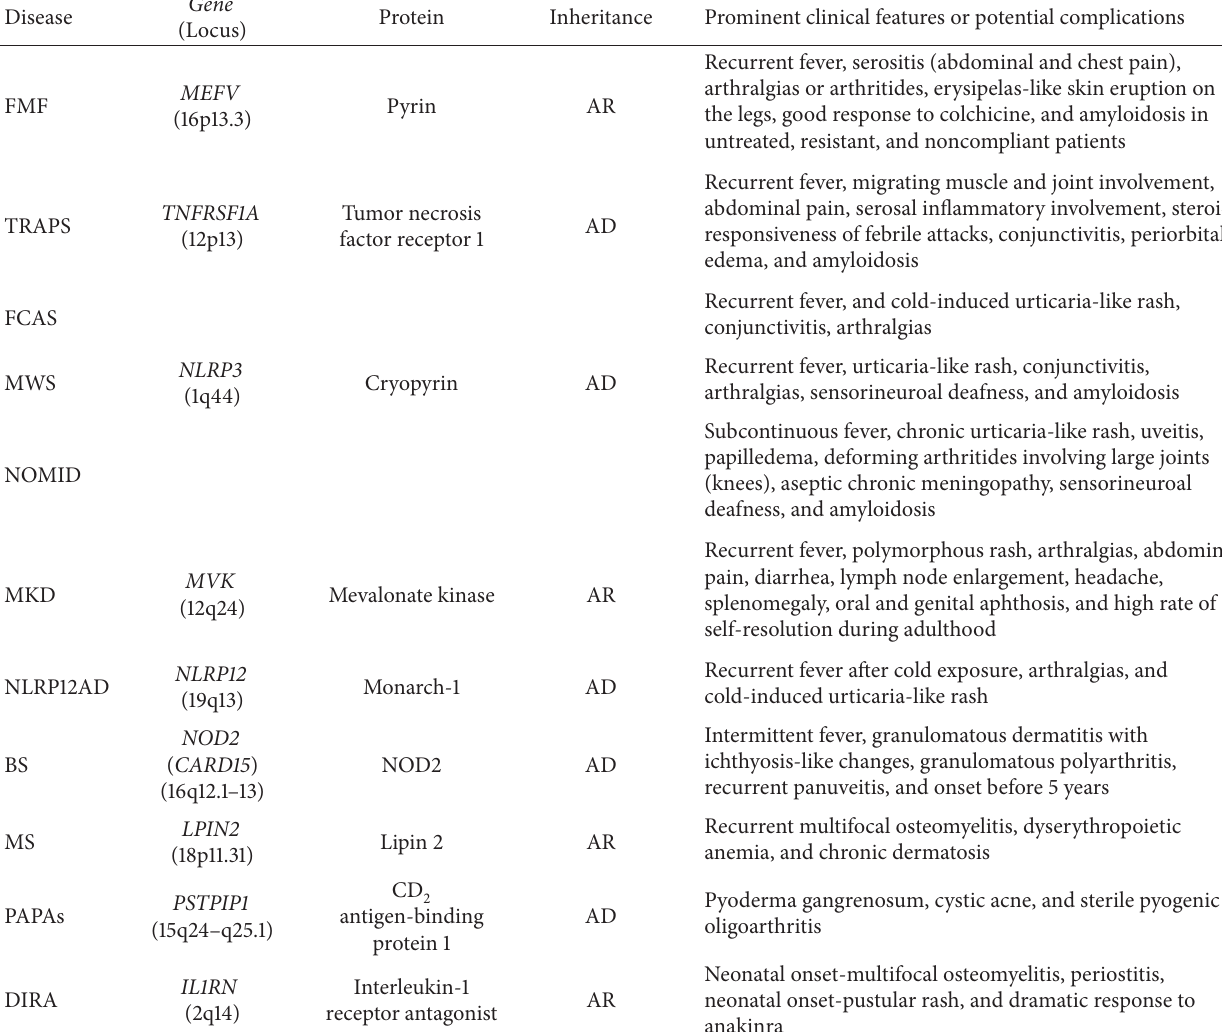
Table 1: Basic genetic and clinical keys of the monogenic autoinflammatory disorders discussed in the review. Disease Protein Inheritance Prominent clinical features or potential complications Recurrent fever, serositis (abdominal and chest pain), arthralgias or arthritides, erysipelas-like skin eruption on AR the legs, good response to colchicine, and amyloidosis in untreated, resistant, and noncompliant